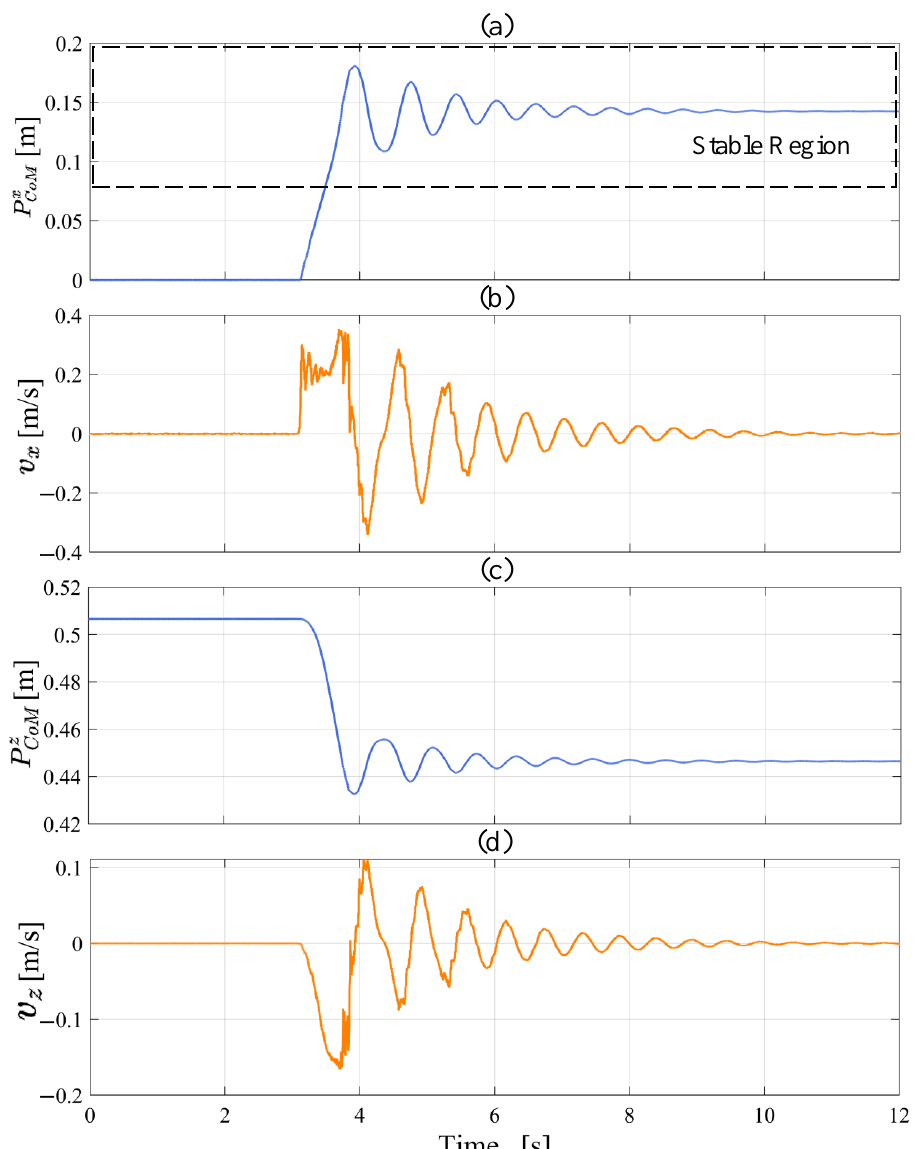
Figure 15. The position and velocity data of the CoM during the kneeling down experiment ( a – d ).